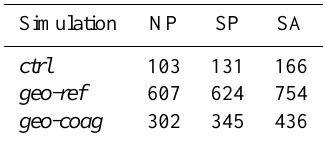
Table 3. Mean cloud-top cloud droplet number concentration (cm − 3 ) averaged over cloudy time steps for the geoengineered re- gions in North Pacific (NP), South Pacific (SP), and South Atlantic (SA) as shown in Fig. 6.